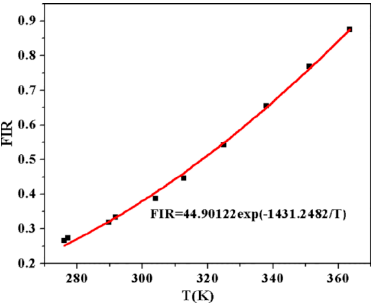
Figure 5. FIR of upconversion emission band as a function of temperature ranging from276 to 363 K.